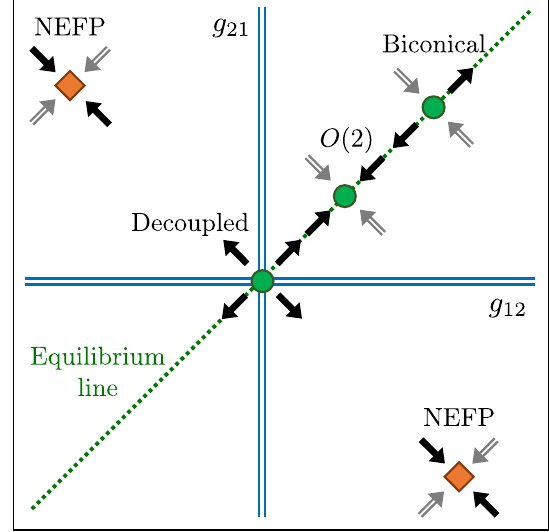
FIG. 2. A schematic RG flow diagram projected to the g 12 − g 21 plane. (The full RG flow requires a five-dimensional space, which precludes a more complete sketch of the RG flow in this two- dimensional space; see Sec. IV.) In addition to the equilibrium fixed points where g 12 ¼ g 21 (green circles), a pair of stable NEFPs (orange diamonds) emerge in the sector defined by the opposite signs of g 12 and g 21 . These new fixed points exhibit exotic critical behavior reflecting their truly nonequilibrium nature. Filled (black) arrows represent the stability, while partial (gray) arrows indicate the expected stability of the various fixed points in different directions. Stability is known to lowest order in ϵ ¼ 4 − d only in directions that preserve the ratio g 12 =g 21 . The RG flow cannot cross the g 12 , g 21 axes, which is represented by double lines. The stable equilibrium fixed point is characterized by an emergent O ð 2 Þ symmetry, while the unstable equilibrium fixed points include a biconical fixed point as well as various decoupled fixed points (which all lie at the origin in this diagram) corresponding to combinations of Ising and Gaussian fixed